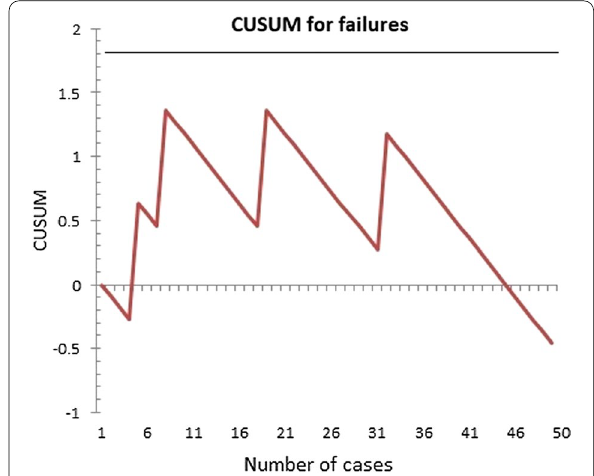
Fig. 6 CUSUM curve for failures; reveals within expected outcomes. The curve remains between the upper and lower CUSUM limits all through the